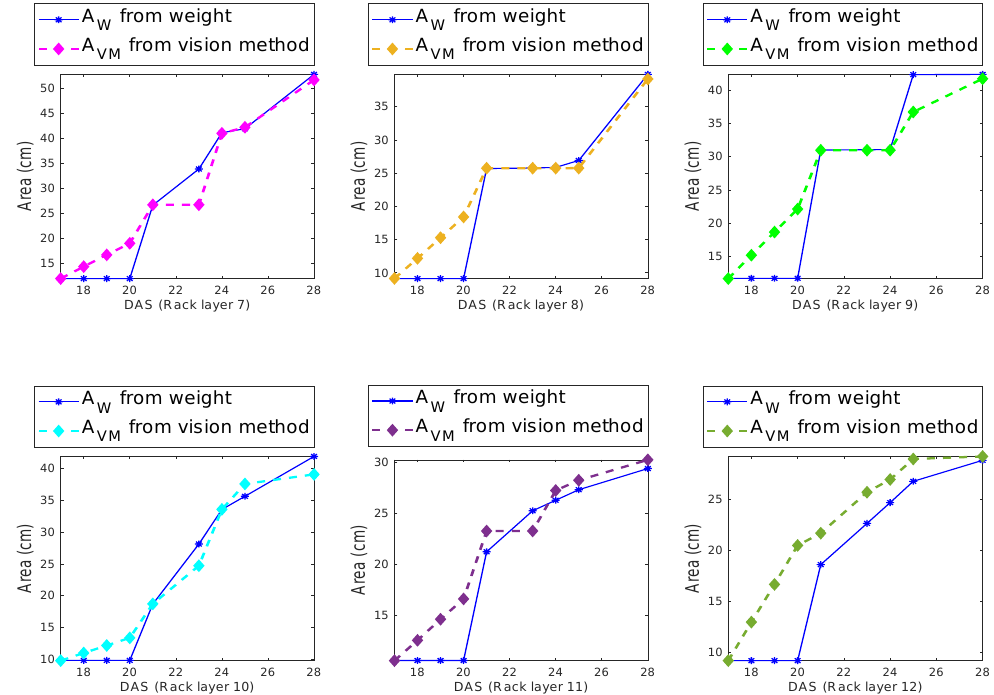
Figure 11. Leaf area trends for both the area computed by training a small set of samples, and by vision method, as described in Section 4.3. Data from vision are given for DAS 18–28, while the leaf area computed by the network, using the manually measured weights is only for DAS 21, 24, 25 and 28,